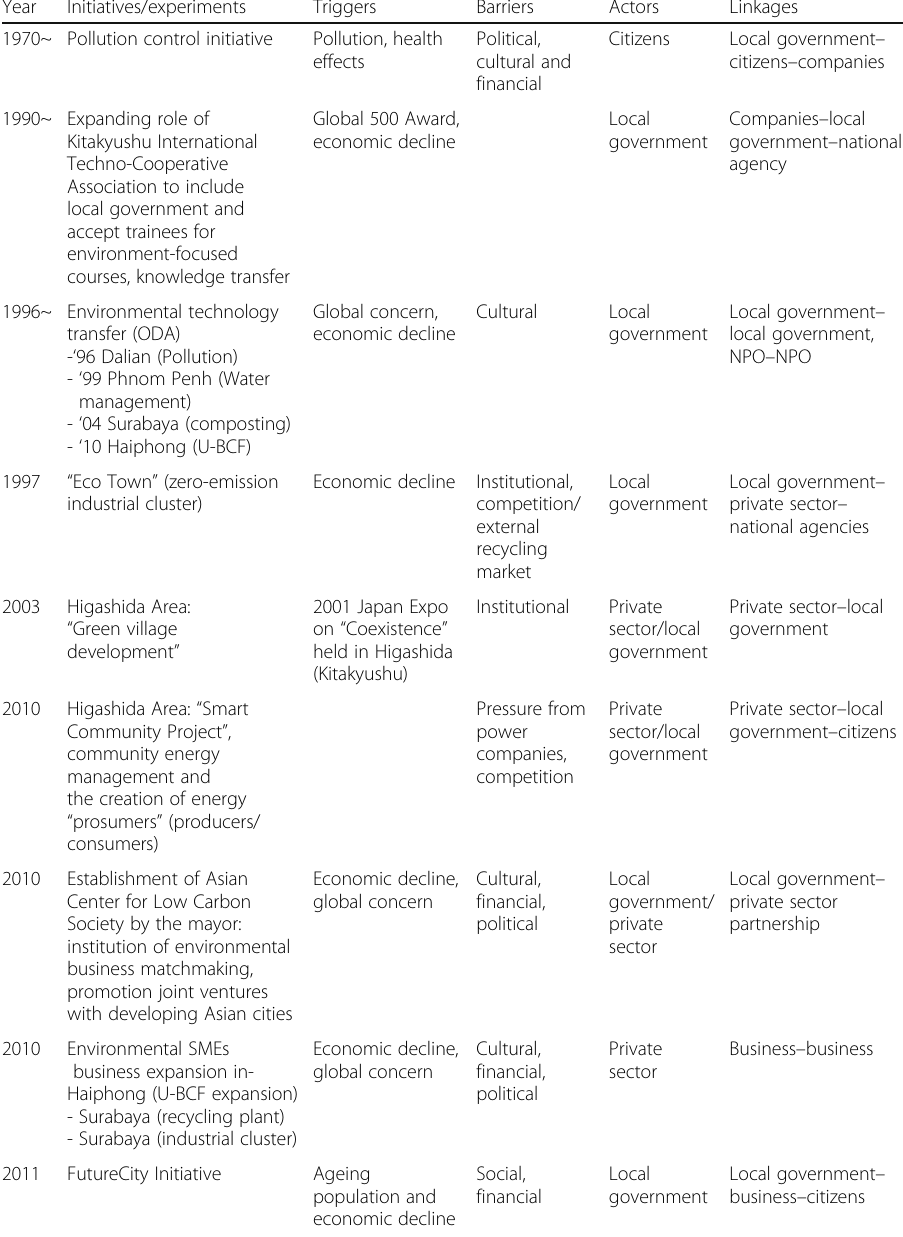
Table 2 Experiments and related key triggers, actors, barriers,